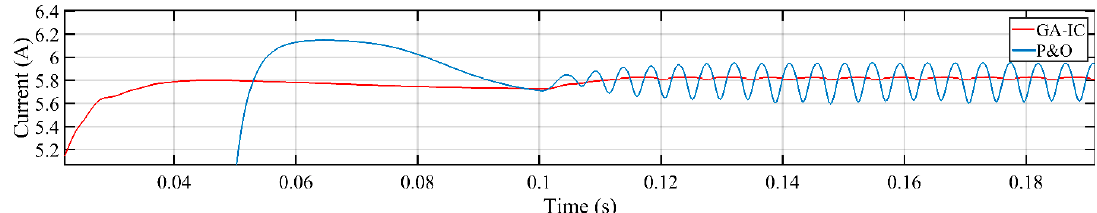
Table 7. Quantitative performance comparison of the GA-IC with P&O.